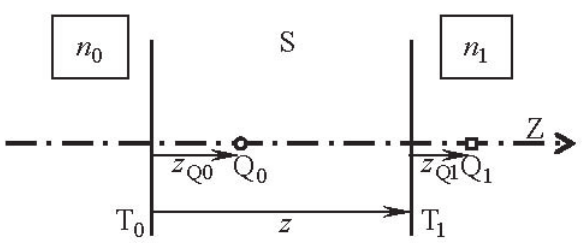
Figure 2 Incident special point Q 0 of system S is located at longitudinal position Z Q0 relative to entrance plane T 0 . Emergent special point Q 1 is located at position Z Q1 relative to exit plane T 1